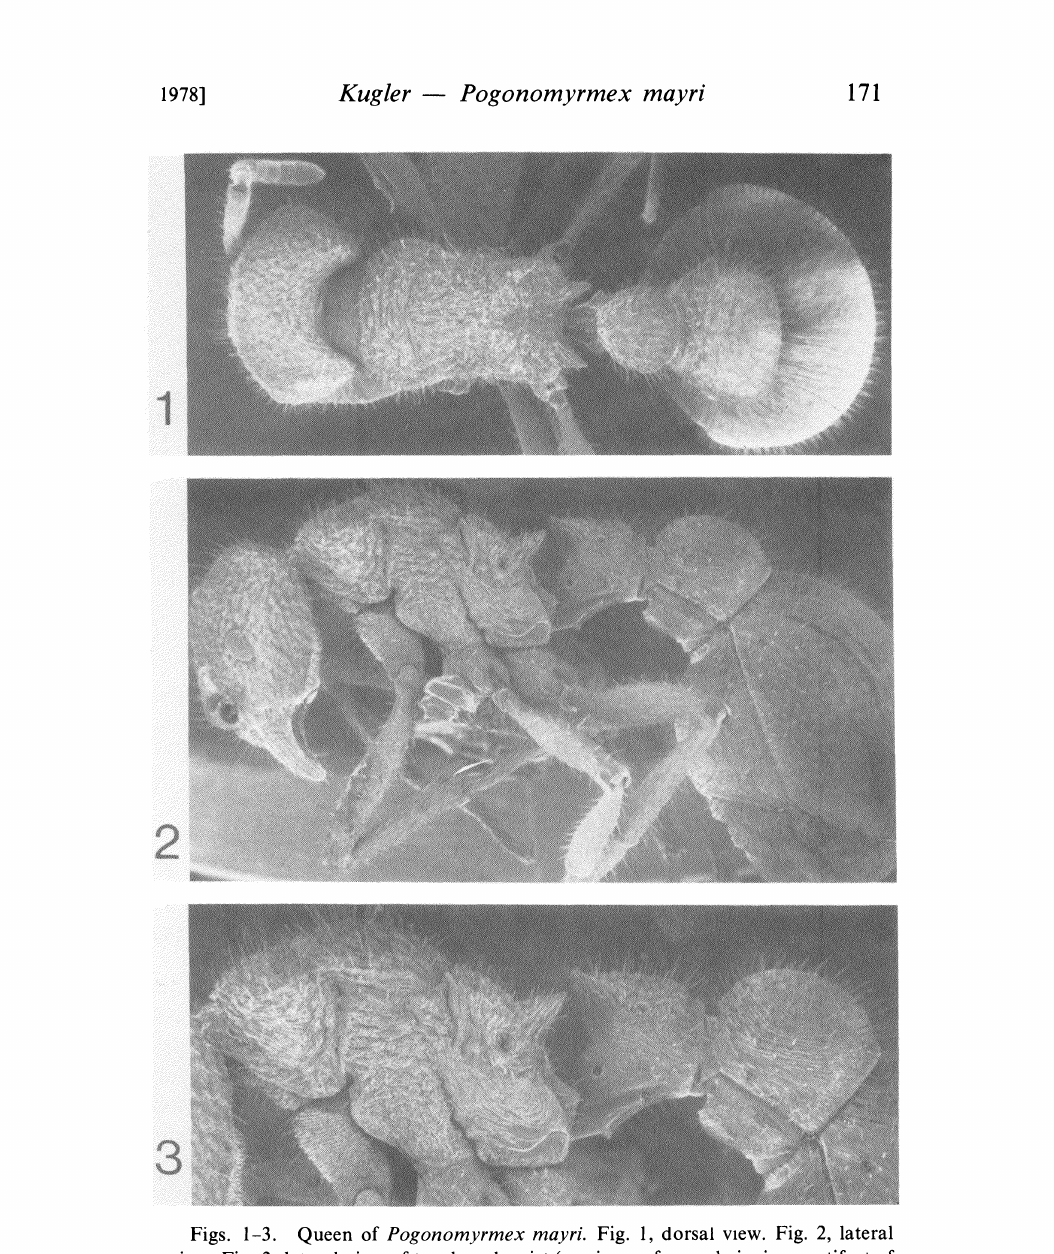
Figs. 1-3. Queen of Pogonomyrmex mayri. Fig. 1, dorsal wew. Fig. 2, lateral view. Fig. 3, lateral view of trunk and waist (waviness of some hairs is an artifact of